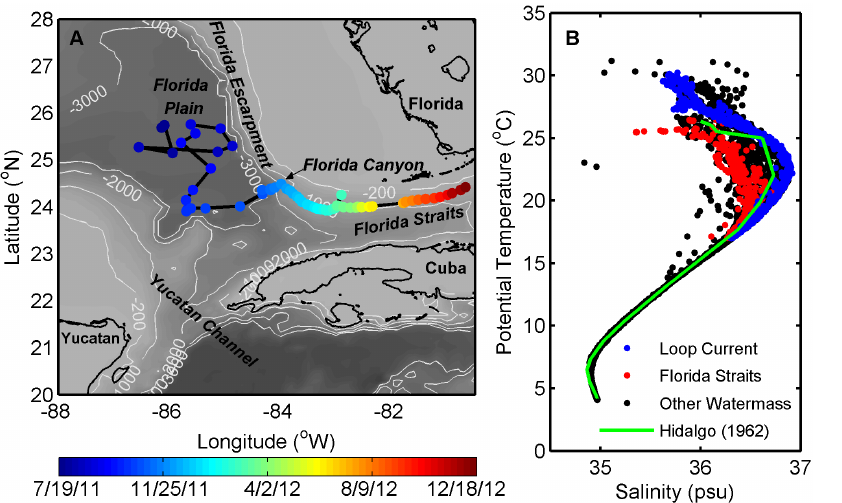
Figure 1. Map of float surface position in the Gulf of Mexico and T-S diagram for the deployment. (A) Float surface position, starting with its deployment on July 19 th , 2011 and showing each surfacing (circles), until its last useful profile on December 18 th , 2012. Note that profiles are not evenly spaced in time (see Methods). (B) T-S diagram for the float deployment demonstrating characteristic shape for the GOM, including profiles associated with the LC, Florida Straits, and all other water masses sampled. The T-S relationship compares well with an example profile from the historic Hidalgo (1962) cruise.